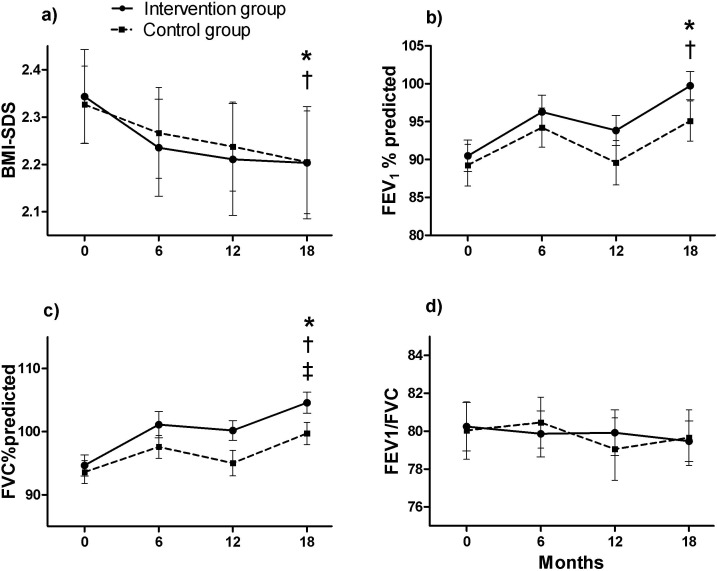
Changes over time in: a) BMI-SDS, b) FEV1%predicted, c) FVC%predicted, d), FEV1/FVC (in %) §. Data are presented as mean (SEM). *: Significant difference over time in the intervention group (p<0.05). †: Significant difference over time in the control group (p<0.05). ‡: Significant difference between intervention and control group over time (p<0.05). §: Intention to treat analyses are presented. Abbreviations: BMI-SDS: body mass index standard deviation score, FEV1%predicted: forced expiratory volume in 1 second in %predicted, FVC: forced vital capacity in %predicted.